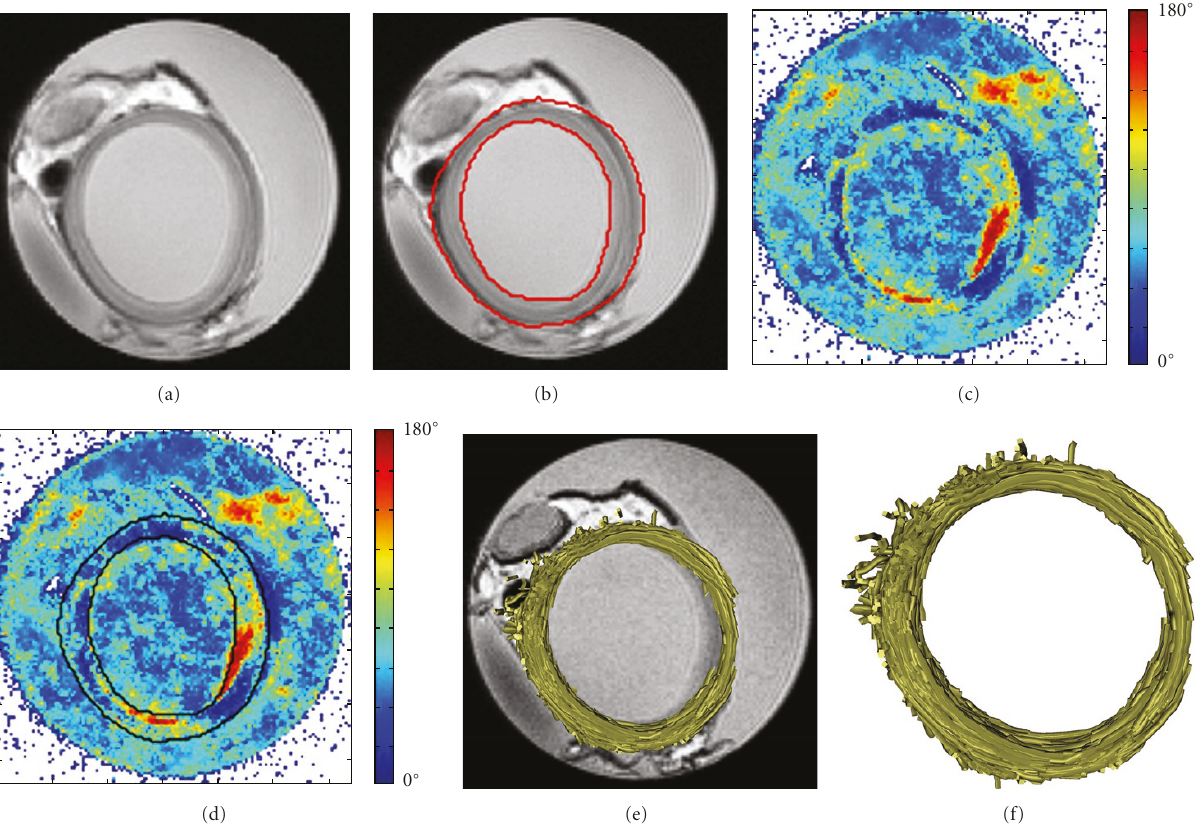
Figure 3: Steps in the DTI procedure and image postprocessing; (a) MRI anatomical scan, (b) the ROI of the aorta, (c) a map of the angle of the first eigenvector with the x-y plane, (d) a map of the angle of the first eigenvector with the x-y plane with the ROI clearly identified, (e) the results of the tractography process with the fibres superimposed on the reference image, and (f) the aortic fibres within the ROI